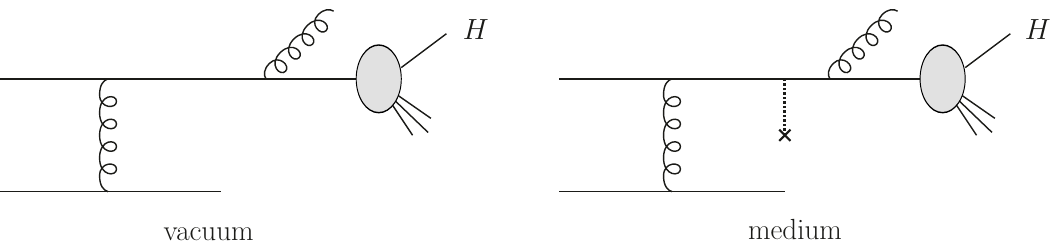
Figure 5 . Real-emission corrections at next-to-leading order in QCD for inclusive hadron produc- tion. The vacuum case (proton-proton) is shown on the left hand side and the medium induced diagram (Pb+Pb) is shown on the right. The gray ellipses represent the standard vacuum frag- mentation functions for the inclusive production of a hadron H . The dotted line represents the interaction with the medium. See text for further